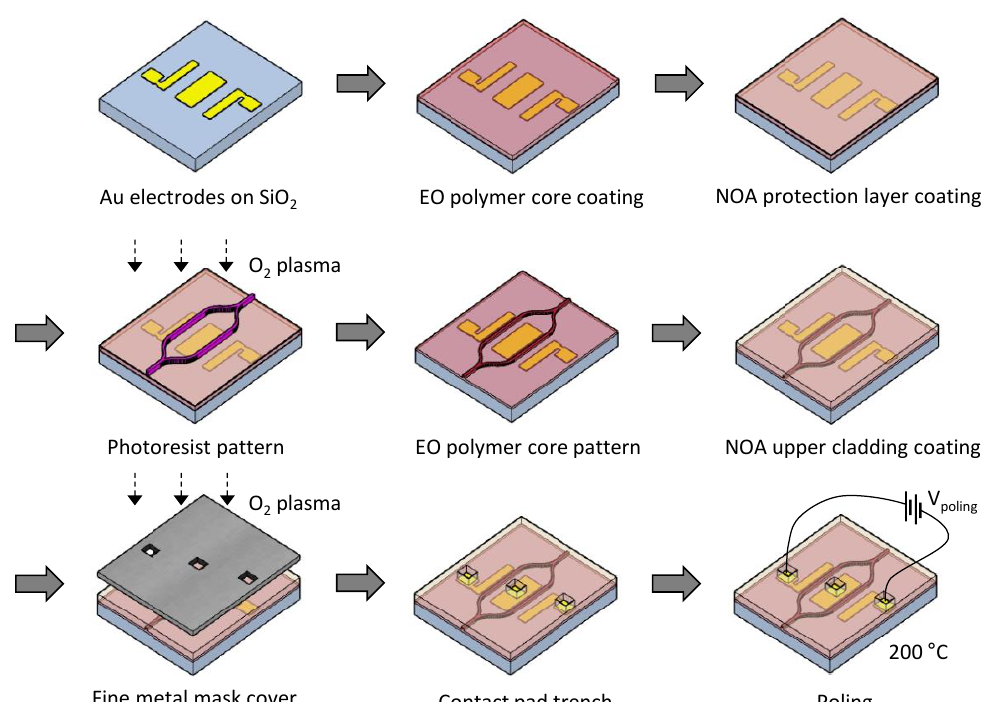
Figure 4. Schematic fabrication procedure of the EO polymer Mach–Zehnder modulator with a coplanar electrode.